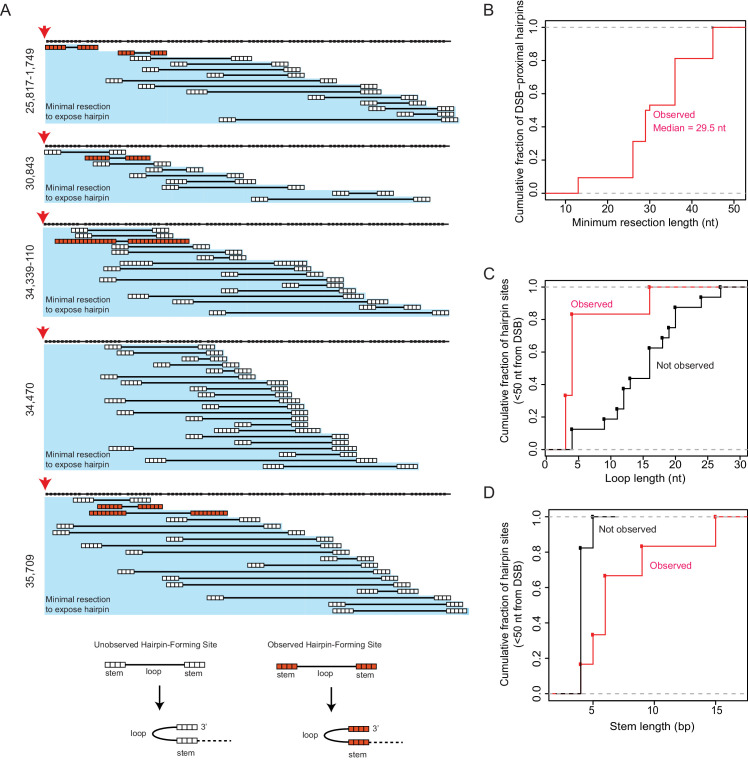
Distribution of potential hairpin-forming sites centromeric to the induced DSBs.(A) For each of the 5 CRISPR/Cas9-induced DSB sites, the bases centromeric to the DSBs (red arrows) are shown as black squares across the top line; every 10th base from the DSB is not displayed. Below the top line, potential hairpins are shown such that bases associated with the stems are white squares (an unobserved hairpin) or orange squares (an observed hairpin) and bases associated with the loop are shown as solid black lines (see the bottom of the panel). The minimal amount of resection required to expose all of the bases of the potential hairpin are shown with the blue background. Only potential hairpins that are exposed by 100 nt or less of centromeric resection from the induced DSB are shown. (B) A plot of the cumulative distribution of required resection lengths for all of the observed hairpin-forming sites displayed in panel A; the maximum observed resection is less than 50 nt, and the median is 29.5 nt. (C) The cumulative distribution of hairpin loop lengths for observed hairpin-forming sites (red) and hairpin-forming sites that were not observed (black) exposed by 50 nt or less resection on the centromeric side of the induced DSBs. (D) The cumulative distribution of hairpin stem lengths for observed hairpin-forming sites (red) and hairpin-forming sites that were not observed (black) exposed by 50 nt or less resection on the centromeric side of the induced DSBs.